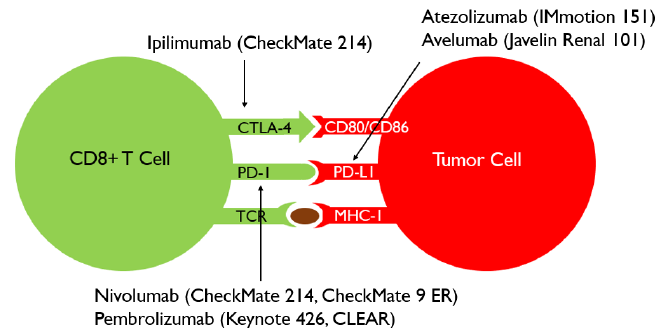
Figure 3. Schema of tumor induced T-cell anergy and immuno-oncology agents. Ipilimumab–anti- CTLA4 monoclonal antibody. Nivolumab–anti-PD-1 monoclonal antibody. Pembrolizumab-anti- PD-1 monoclonal antibody. Atezolizumab-anti-PD-L1 monoclonal antibody. Avelumab-anti-PD-L1 monoclonal antibody.